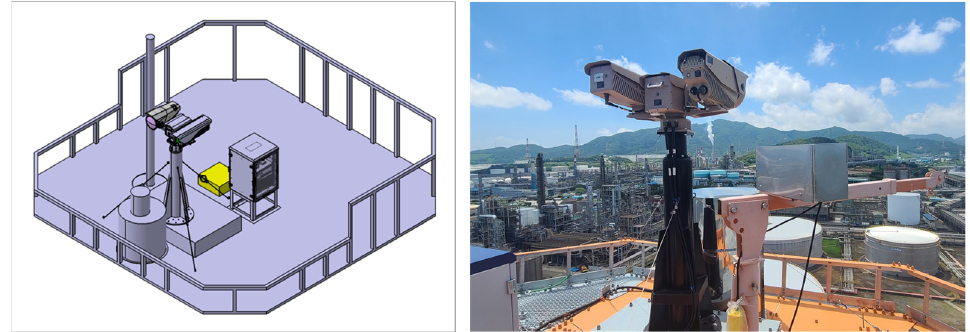
Figure 6. The three-dimensional (3D) drawing ( left ) and photograph ( right ) of the equipment installed on the steel tower top at the Jeongnyang site.